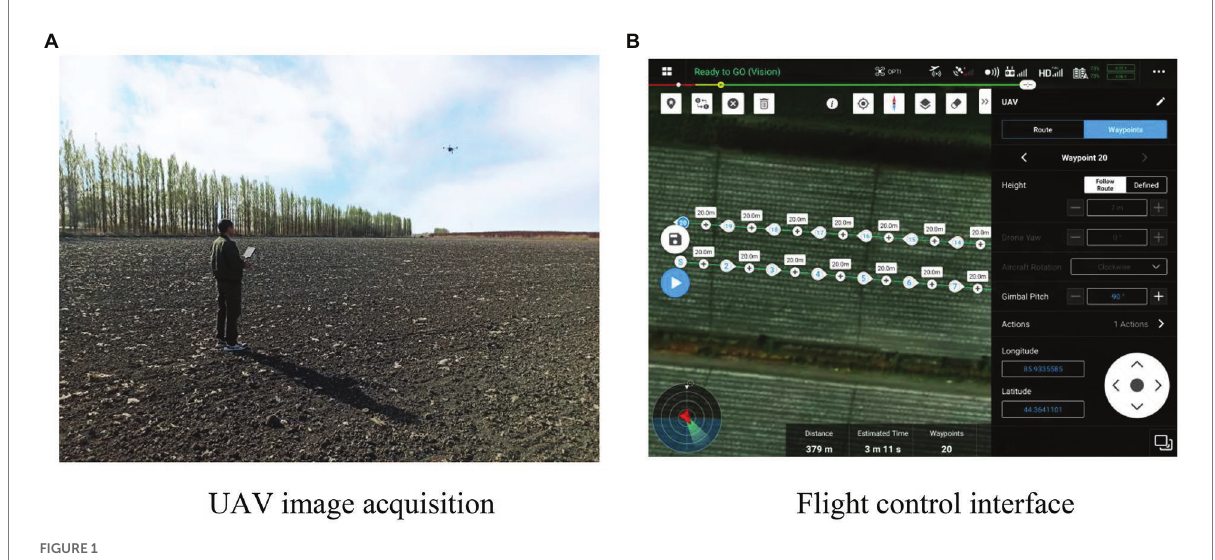
FIGURE 1 UAV image acquisition (A) and flight control parameters (B)